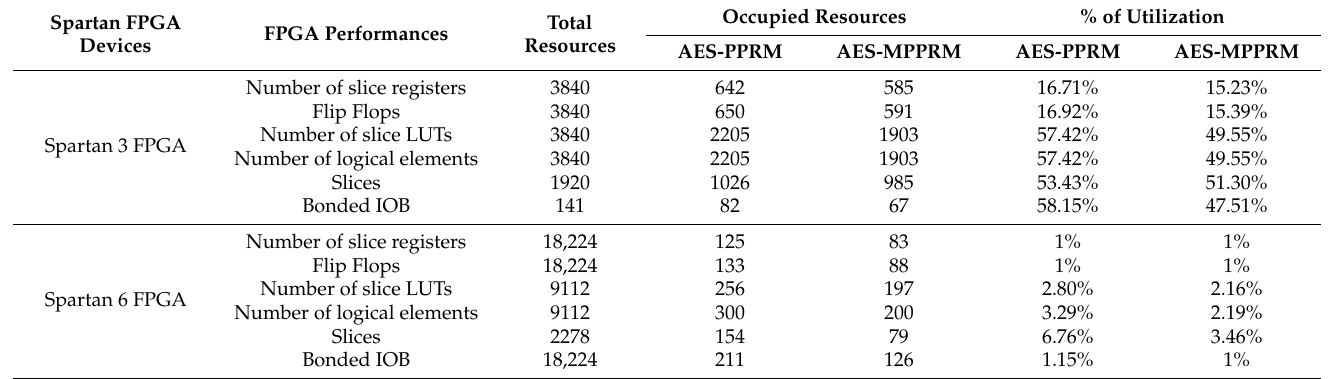
Table 4. Hardware utilization analysis of AES-MPPRM for Spartan FPGA devices.